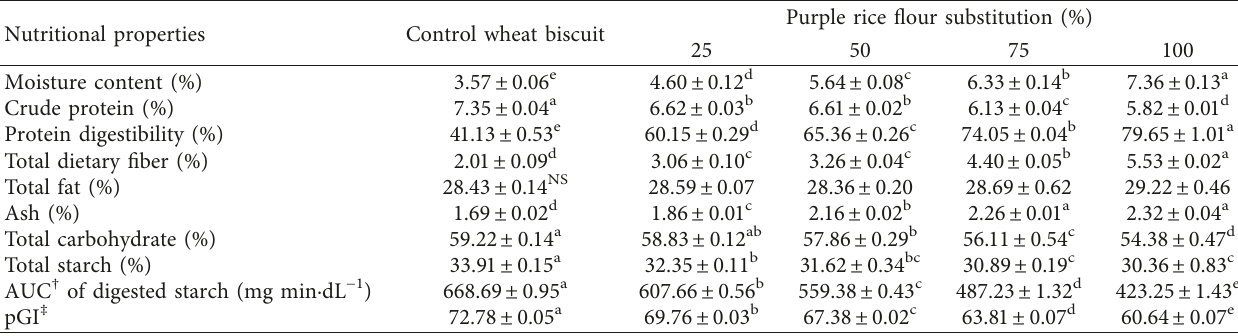
Table 2: Basic characteristics of the biscuits containing different levels of purple rice flours ∗ . Nutritional